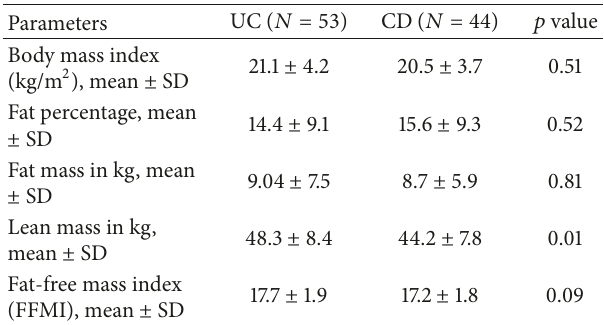
Table 2: Comparison of body composition between patients of Crohn’s disease and ulcerative